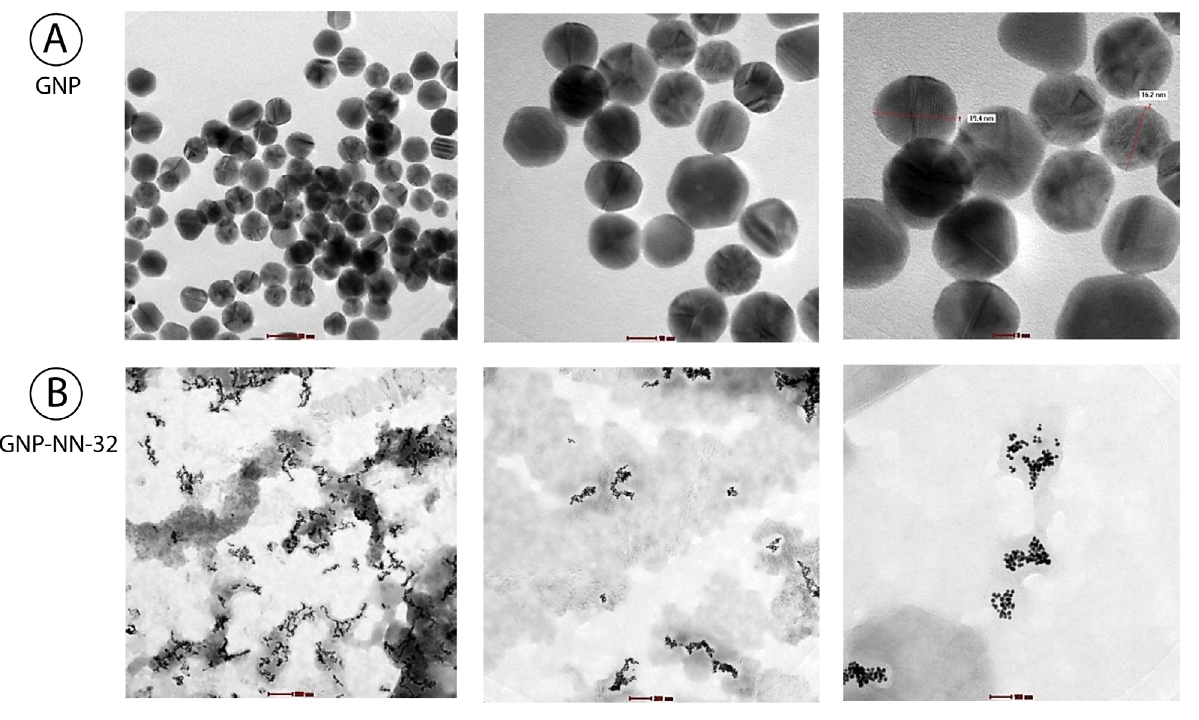
Figure 3. Characterization of GNP-NN-32 by TEM. (A) GNP, (B)